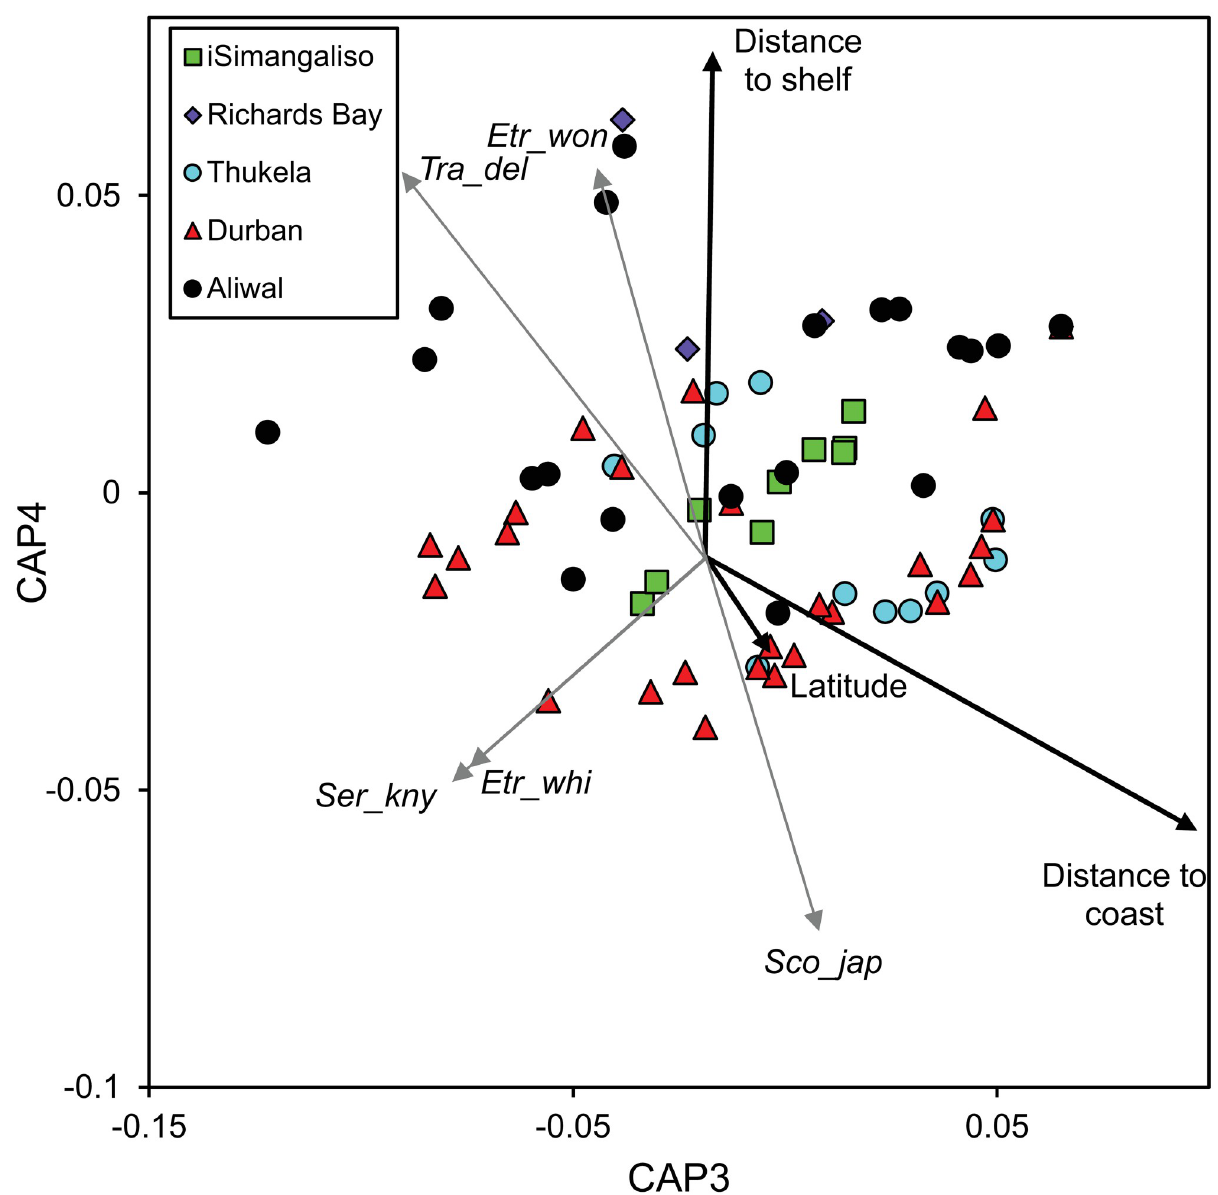
Fig 5. Constrained multidimensional scaling ordination derived from a canonical analysis of principle coordinates of ichthyoplankton samples, plotted according to transect. Vectors of the correlations of the significant environmental variables of interest (black) along with vectors (grey) of those species (abbreviated, see below) with correlations > 0.4 with the third and fourth canonical axes are overlaid onto the ordination. The ordination accounted for 26% of the variation and the third and fourth squared canonical correlations were 0.17 and 0.04, respectively. Ben_pte = Benthosema pterotum , Emm_nit = Emmelichthys nitidus , Eng_cap = Engraulis capensis , Etr_whi = Etrumeus whiteheadi , Sco_jap = Scomber japonicus , Tra_del = Trachurus delagoa